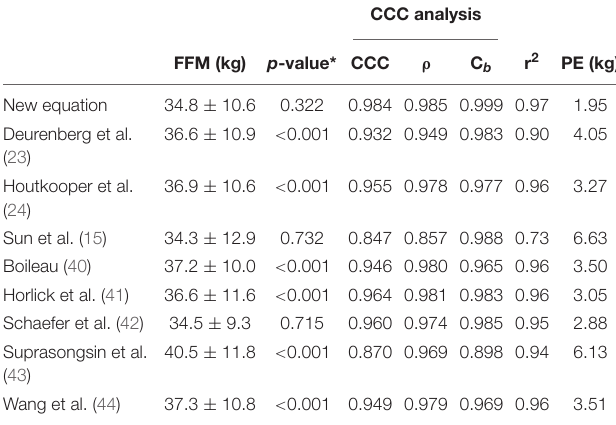
FFM, fat-free mass; CCC, concordance correlation coefficient; ρ , accuracy; C b , validity; PE, pure error. *Differences between predictive equations and reference method by paired t